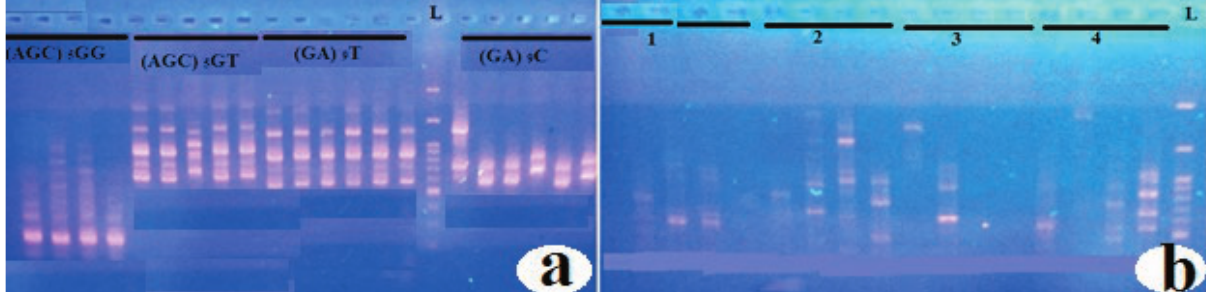
Figure 2. Amplification of DNA from Tamarix leaf using five different extraction methods by ISSR amplification. Note . Fig. 2. a) Nalini et al. (2003); Fig. 2. b) 1- Murry and Thompson (1980); 2- Kit (DNP TM Kit), 3- Sahu et al. (2012), 4- Bi et al. (1996); L) 100 bp DNA